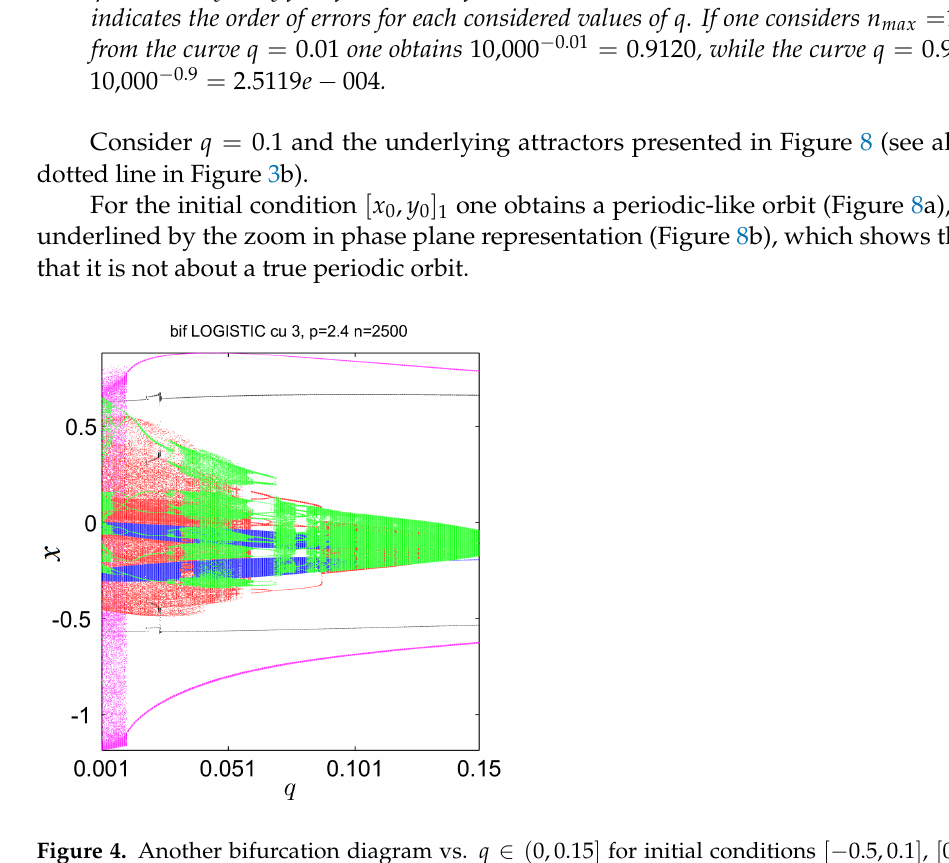
Figure 4. Another bifurcation diagram vs. q ∈ ( 0,0.15 ] for initial conditions [ − 0.5,0.1 ] , [ 0.2,0.1 ] ,